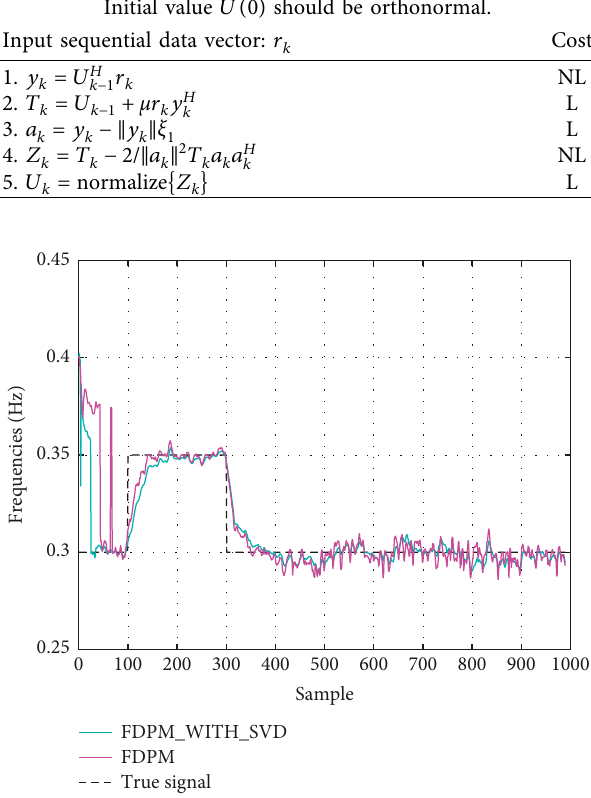
Figure 4: Frequency estimate using FDPM subspace tracking method with exponential widow, a sine signal with 0.3Hz is used to test, μ � 0 . 008, SNR �